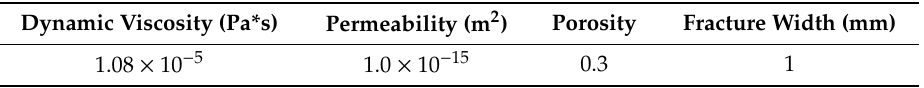
Figure 12. Numerical simulation model in COMSOL. ( a ) Upper fracture model; ( b ) middle fracture model; ( c ) lower fracture model. Table 5. Basic model parameters.